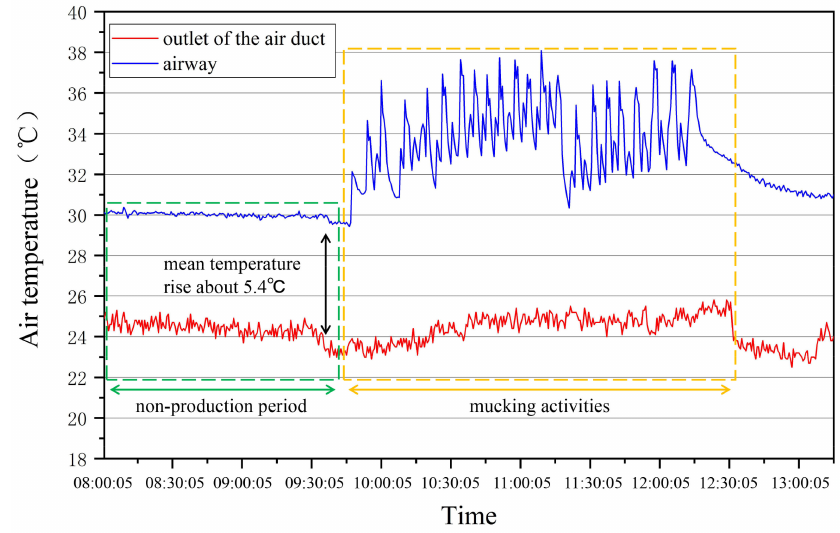
Figure 5. Measured results of the variation in air temperature with respect to